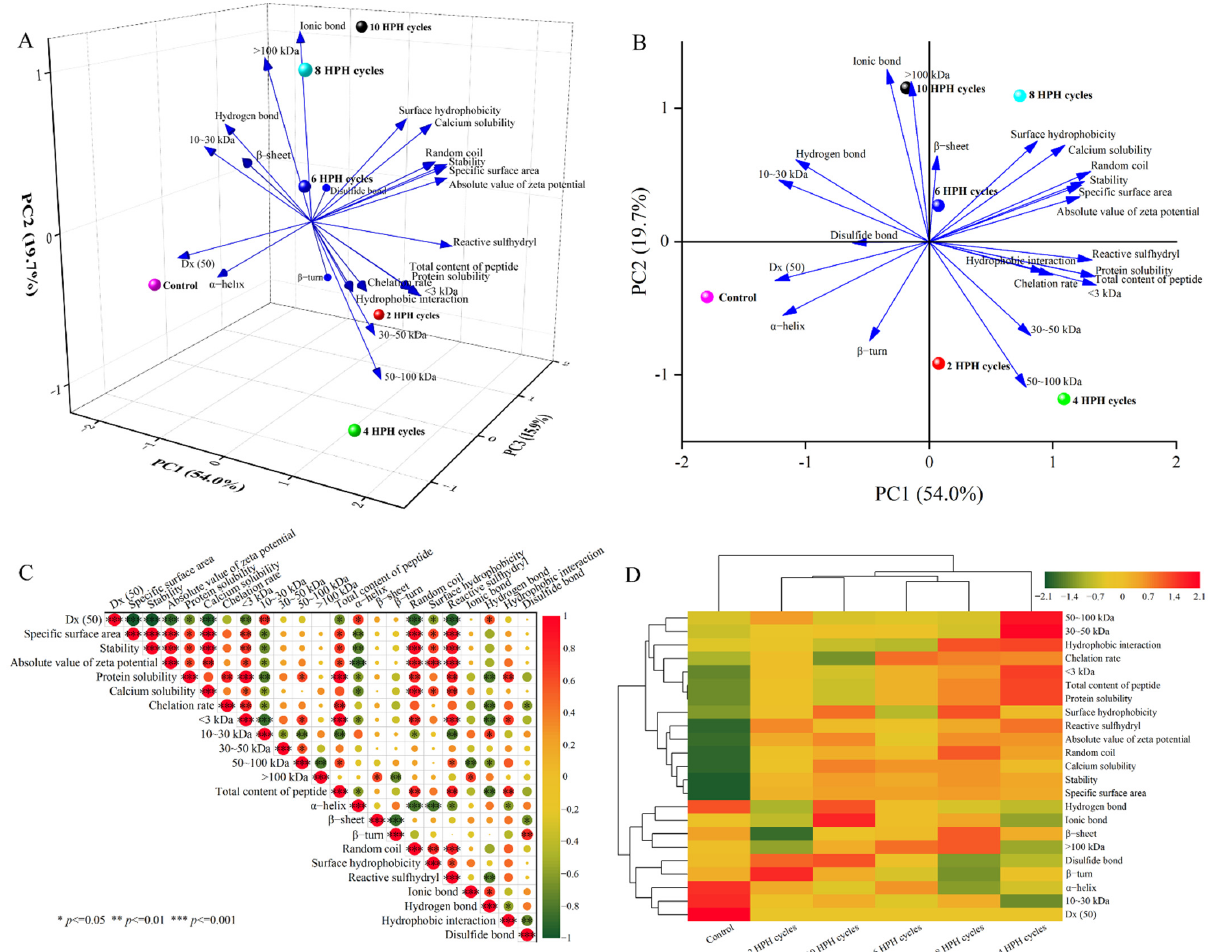
Figure 6. Three − dimensional ( A ) and two − dimensional ( B ) biplots (score and loading) from princi ‐ pal component analysis (PCA) of RBASs show the relationship between quality properties, dissolu ‐ tion characteristics, protein conformation and different HPH treated methods. Correlation heatmap ( C ) among quality properties, dissolution characteristics and protein conformation of RBASs. The color gradation and circle size correspond to the Pearson’s correlation coefficient (r), while the pat ‐ tern with the “*, **, ***” mark represents a significant ( p ≤ 0.05) or extremely significant difference ( p ≤ 0.01 or 0.001). Clustering heatmap ( D ) of quality properties, dissolution characteristics and protein conformation of RBASs. Rows and columns are grouped by correlation distance and average link ‐ age, respectively. The color gradation represents the Z ‐ scores of corresponding parameters.